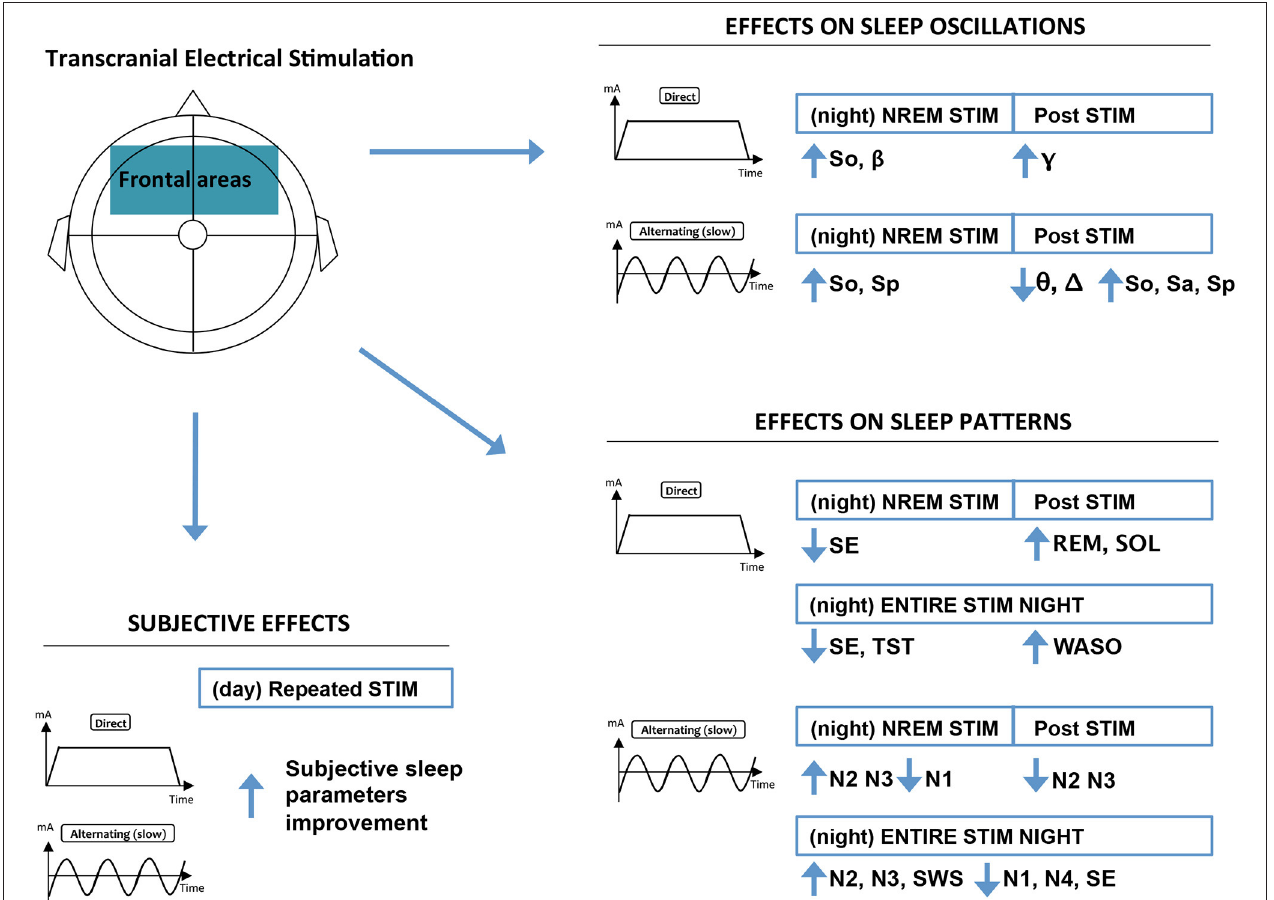
FIGURE 2 | Highlights of major significant effects of frontal tES on sleep. Results regarding non-frontal tES, tES during REM, and fast alternating tES were scarce, and thus omitted from the figure. Effect on sleep patterns: NREM, non-rapid eye movement sleep; N1–4, NREM sleep stages relative duration; REM, rapid eye movement sleep; SE, sleep efficiency; SWS, slow wave sleep relative duration; SOL, sleep onset latency; WASO, wake after sleep onset. Effects on sleep oscillations: β , beta power (15–25Hz); 1 , delta power (1–4Hz); γ , gamma power ( > 25Hz); θ , theta power (4–8Hz); NREM, non-rapid eyes movement sleep; So, slow oscillations power (0.5–1Hz); Sa, slow activity power (0.5–4Hz); Sp, spindle power